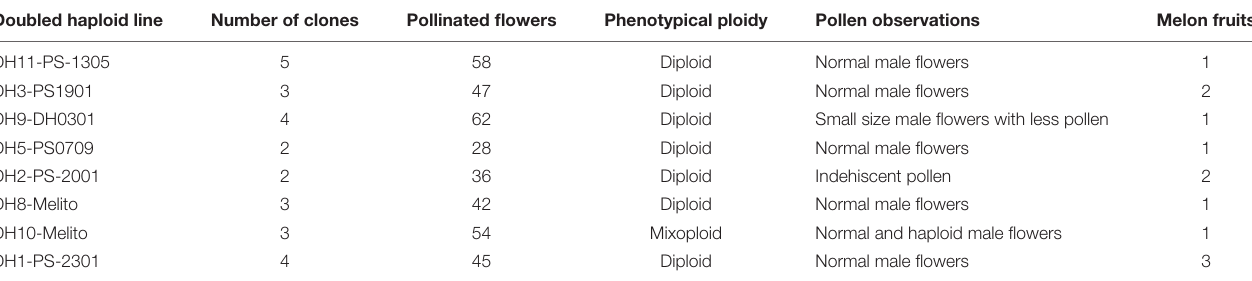
TABLE 5 | Melon fruits recovered from DH